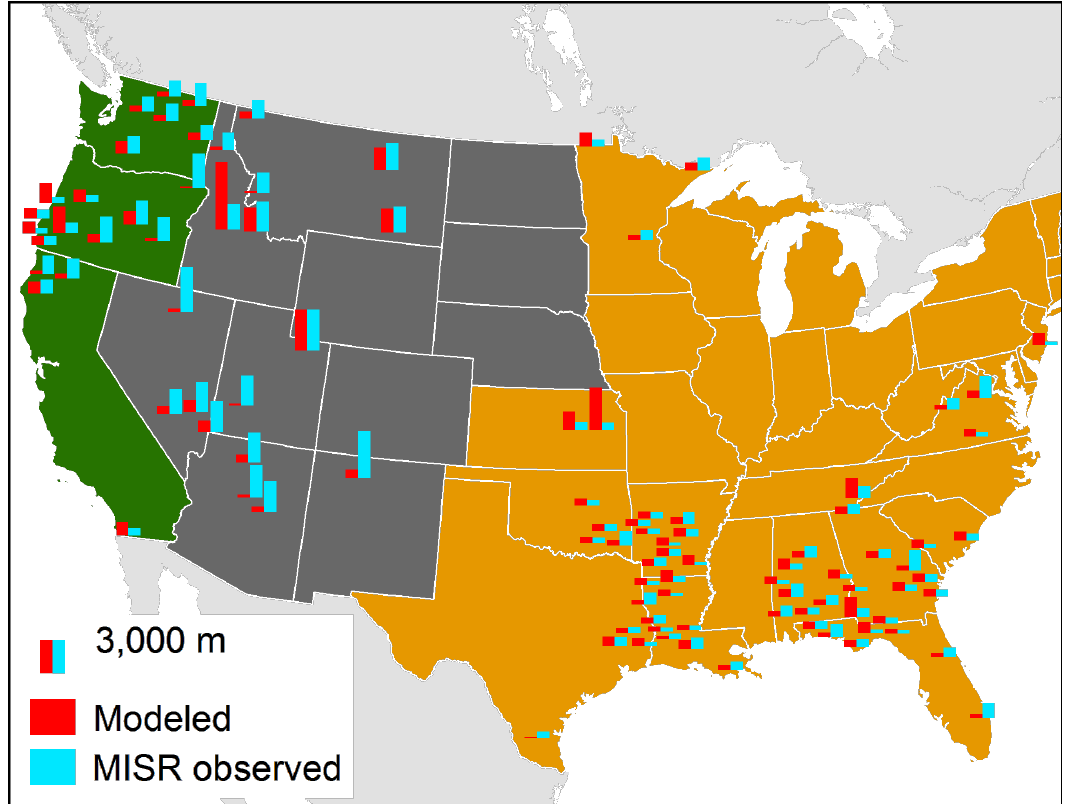
Figure 6. Map of the fire locations and corresponding plume height data from the modeled (red bars) and satellite derived (blue bars) data. Regions are color coded to match data points shown in Figure